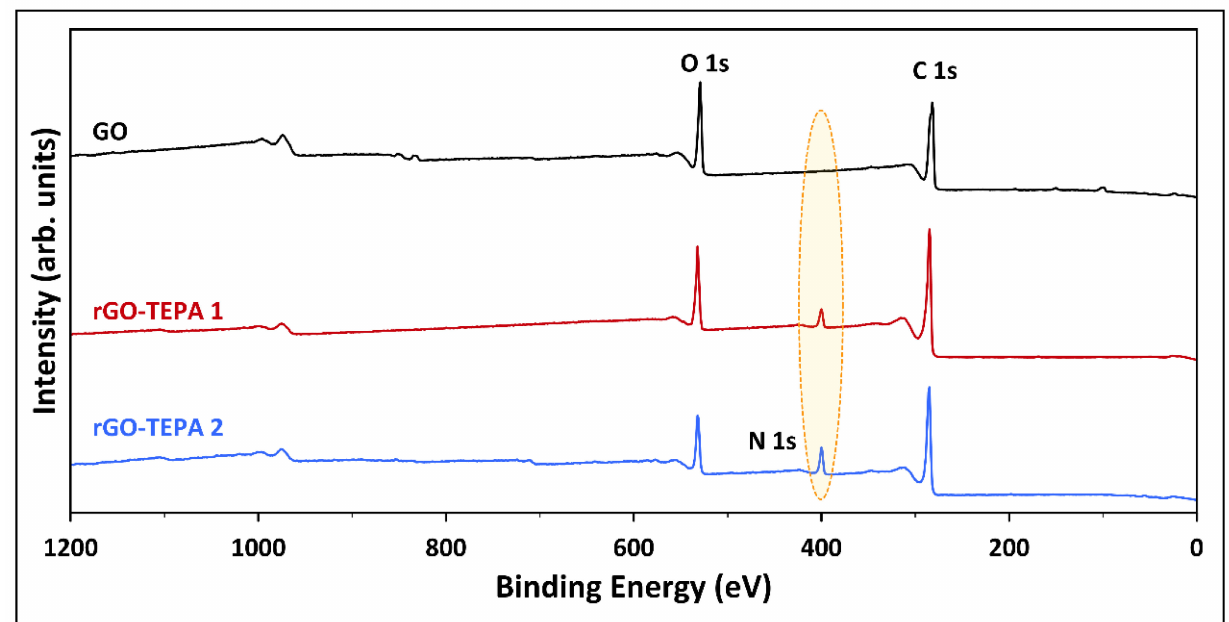
Figure 9. XPS survey of the pristine GO, and rGO-TEPA1 and rGO-TEPA2 nanohybrids. Table 2. Weight compositions of the prepared samples obtained by the CHNO analysis.